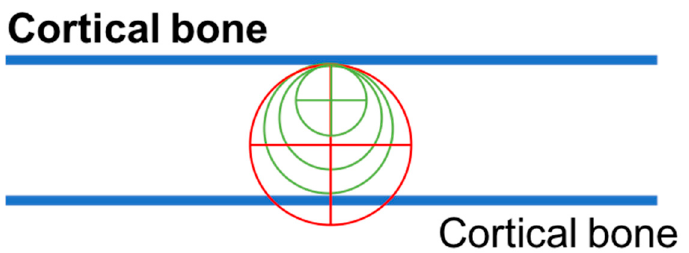
Figure 6. Explanatory drawing of the greatest deviation on the B-L plane with wider drills.